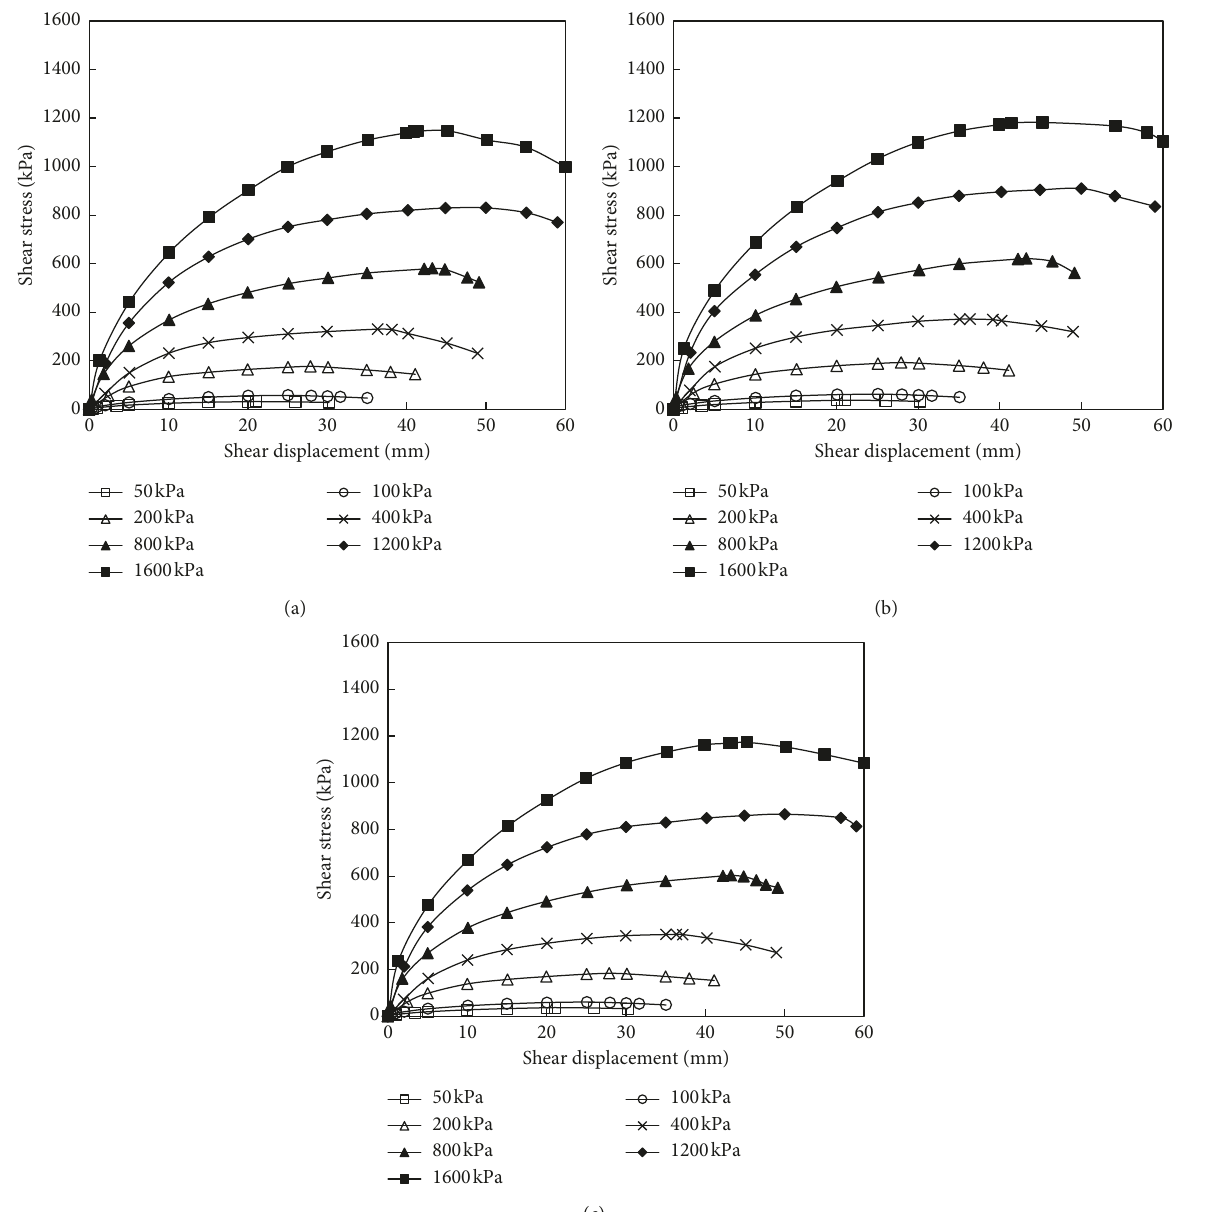
Figure 7: Shear stress-shear displacement curve of different tire specimen sizes at 6% reinforcement ratio. (a) 10mm 30mm 50mm. (c) 50mm × ×